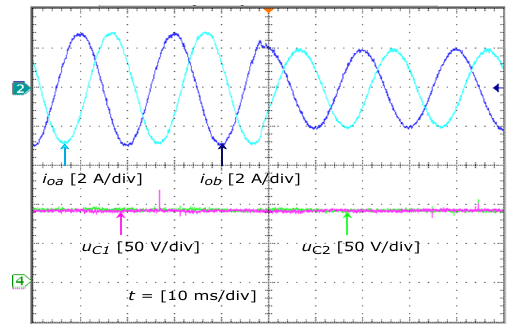
Figure 18. Experimental results for step change in the output